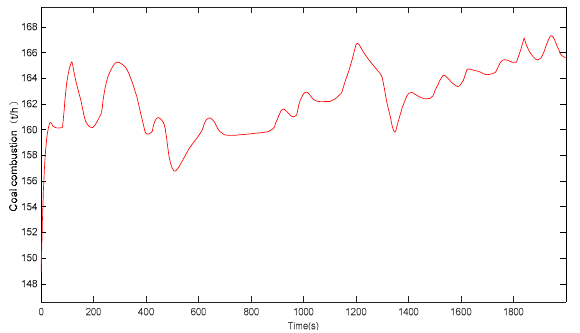
Figure 6. The simulation value of the set of coal.